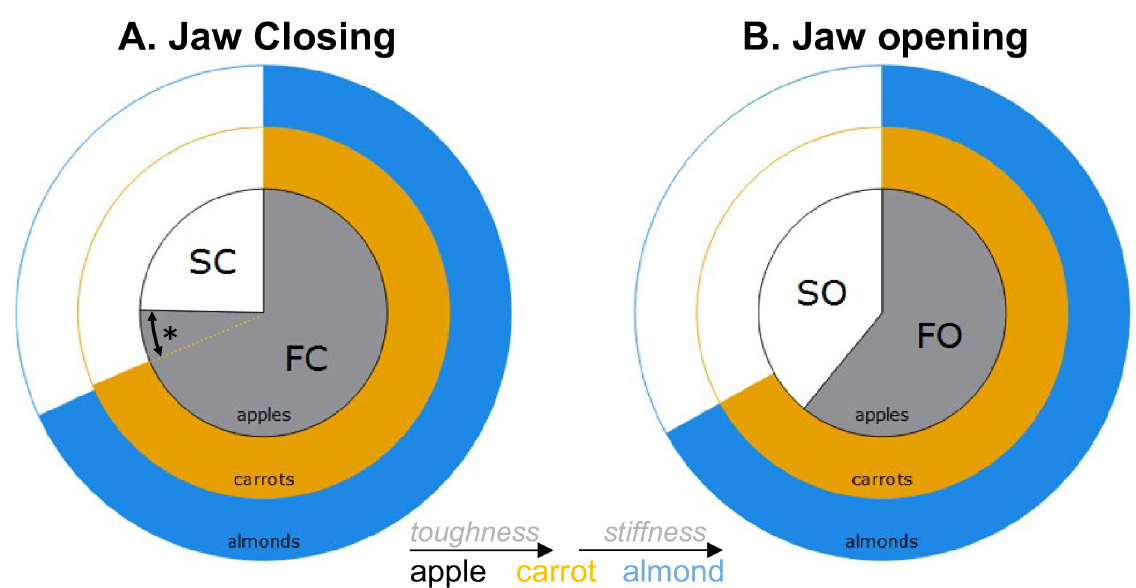
Fig 3. Effect of food toughness and stiffness on the relative amplitude of jaw pitch (Rz). Pie charts illustrate the relative amplitude of ( A ) jaw closing during FC and SC and ( B ) jaw opening during SO and FO. Relative amplitudes are expressed as a % of total amplitude of either jaw opening or closing. Colors represent foods: apples in black, carrots in orange, and almonds in blue. Significant differences between foods are indicated by an � .